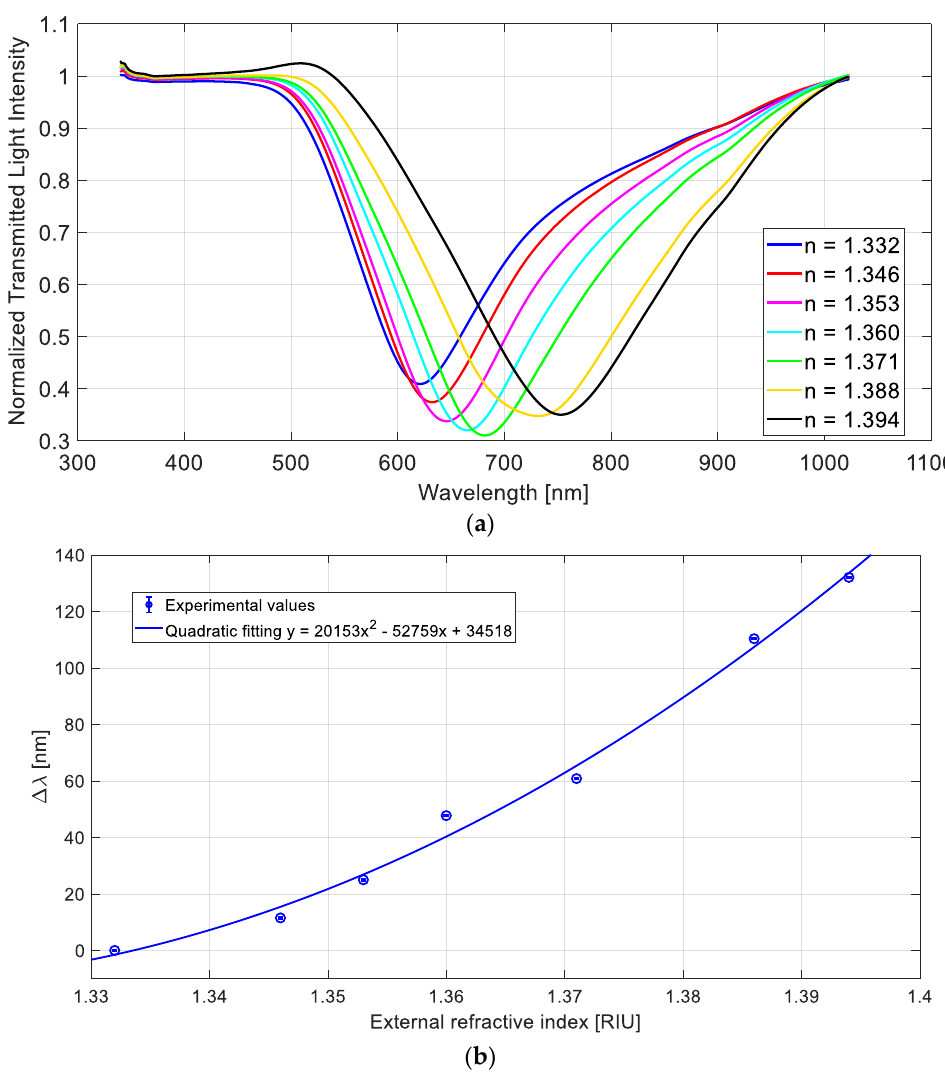
Figure 5. SPR-LDF configuration with a tapered silica LDF probe as a modal filter on the spectrometer side: ( a ) normalized SPR transmission spectra for different refractive index values; ( b ) variation in SPR wavelength (Δλ) versus external refractive index with the quadratic fitting of the experimental data and the error bars.